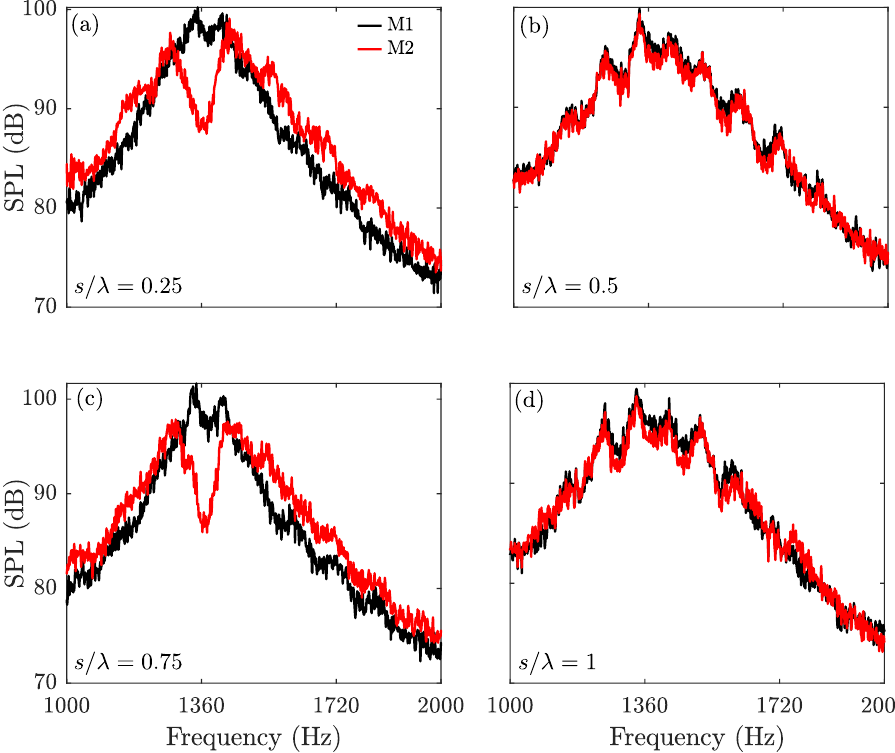
Figure 10. SPL of acoustic signal from microphone M1 and M2 for different spacing configurations between 0.25 < s / λ <1. ( a ) s / λ = 0.25; ( b ) s / λ = 0.5; ( c ) s / λ = 0.75; ( d ) s / λ =